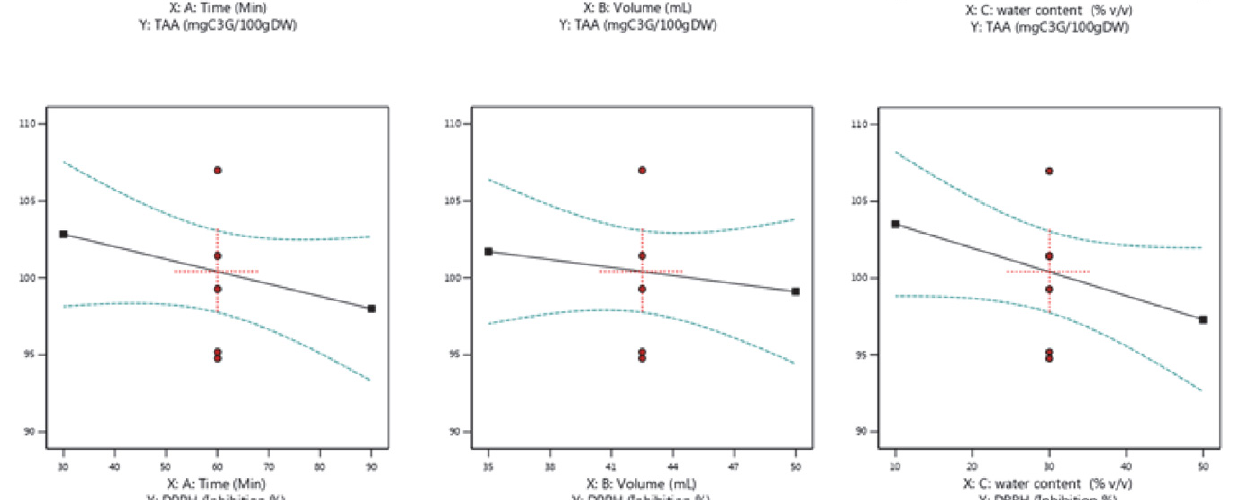
models of the Box-Behnken design have been decided to be satisfactory depending on the statistical indicators such as p < 0.05, R 2 > 0.96 and adjusted R 2 > 0.91. We could optimize the bioactive ingredients in the Rosa canina